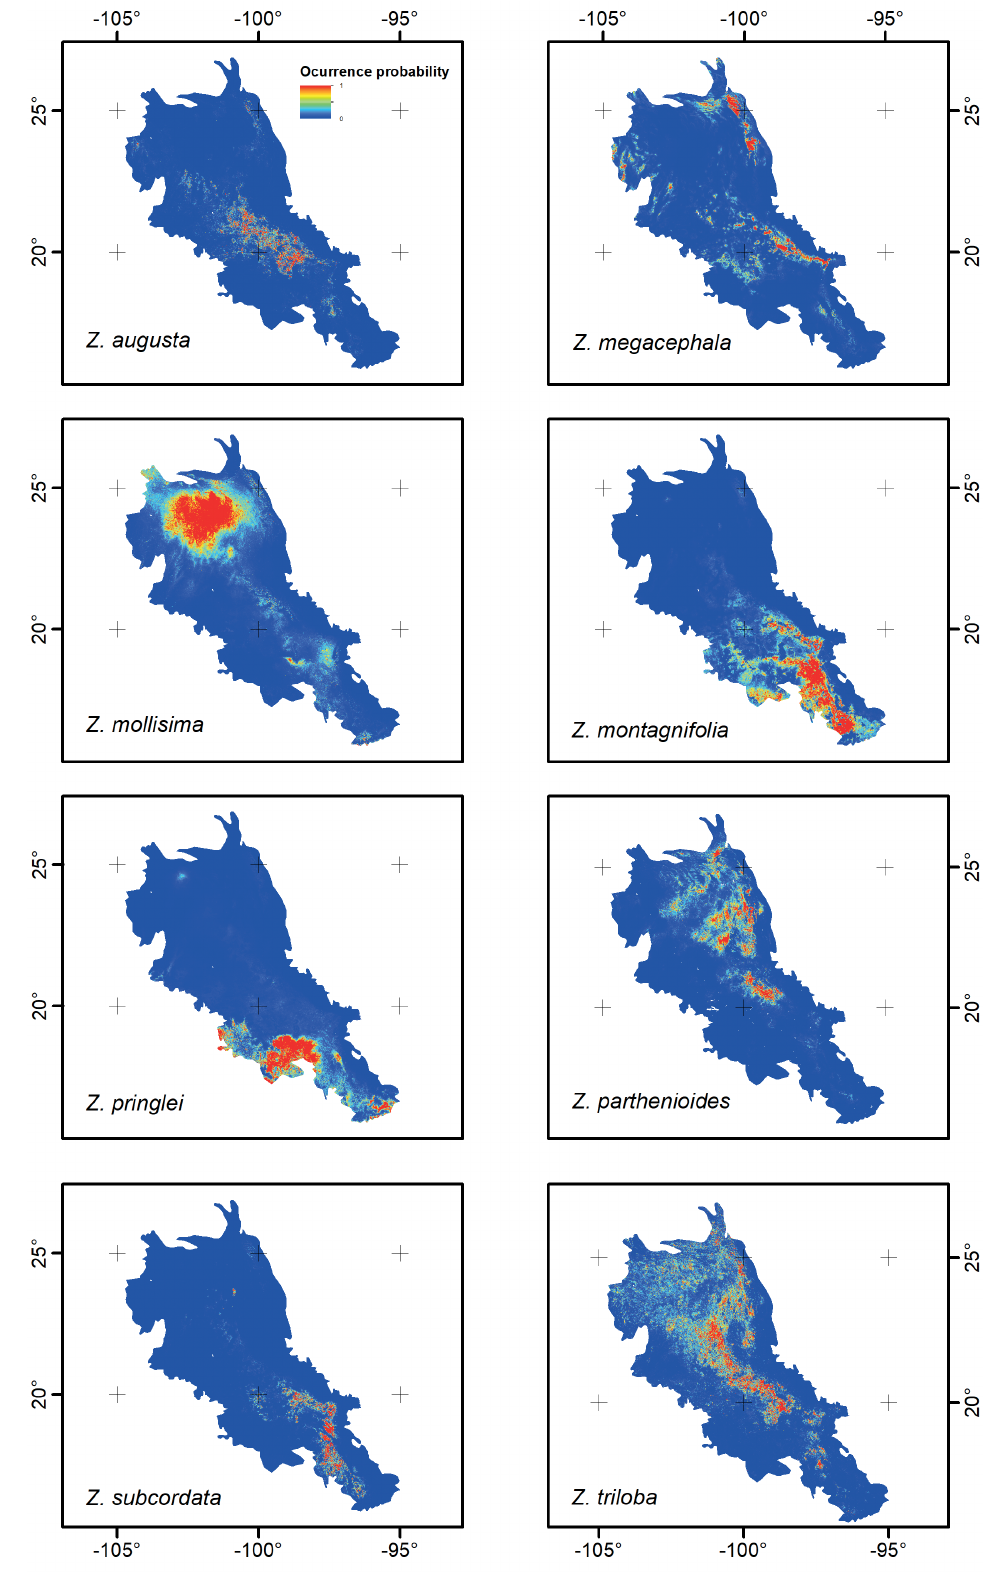
Figure 2 – Potential distribution models obtained for the eight Zaluzania species studied. Maps created using ArcMap 9.3 (https://www. arcgis.com). © Esri and its licensors, all rights reserved. This image is not distributed under the terms of the Creative Commons license of this publication. For permission to reuse, please contact the rights